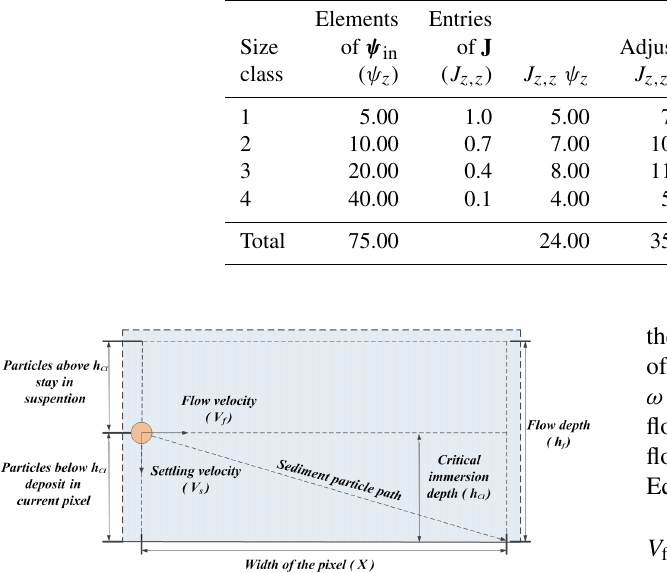
Figure 3. Determination of the critical immersion depth of a sedi- ment